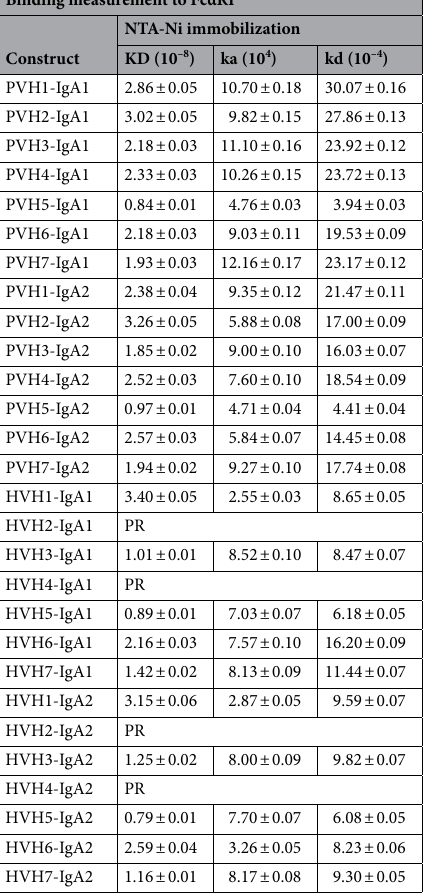
Table 2. BLI measurements of NTA-Ni biosensor immobilized FcαRI interaction to Pertuzumab (PVH) and Trastuzumab (HVH) 1–7 IgA1 and IgA2. The KD, ka and kd values with standard error of each variant are shown accordingly. Poor response (PR) indicates that the antibody construct did not yield reliable ka and kd measurements (in triplicates). All measurements were performed in triplicates and rounded off to the nearest 2 decimal